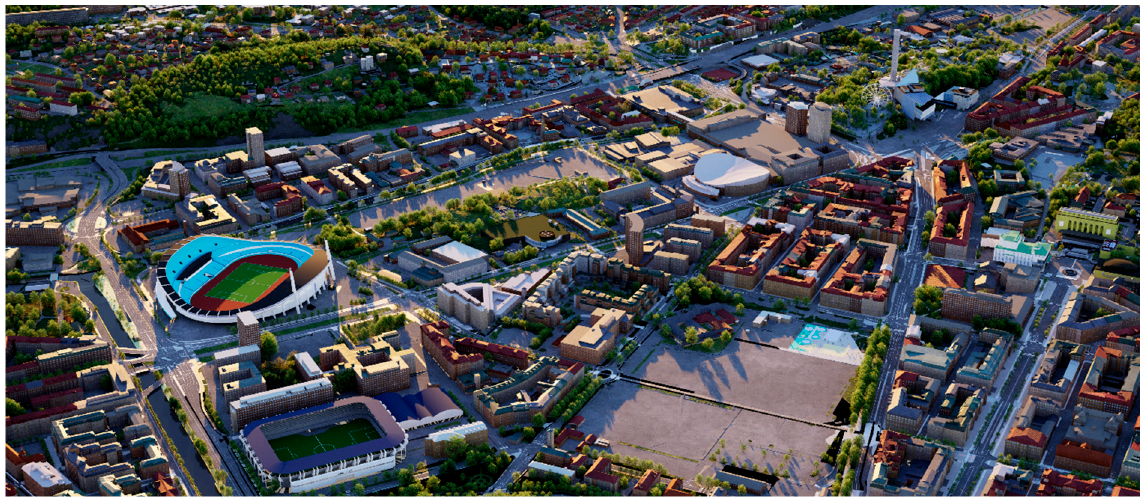
Figure 2. Part of the current 3D model in Gothenburg. The model is constructed by parametric de- sign, but does not yet have any connection to external databases within the